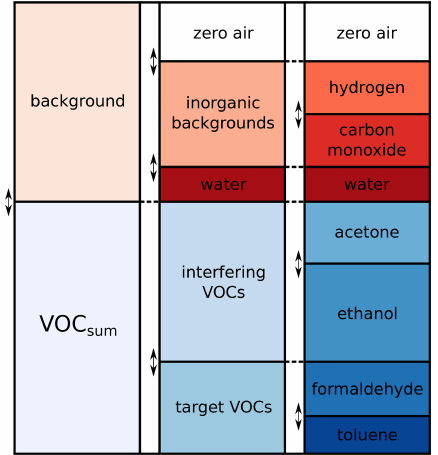
Figure 1. Gas composition for calibration consisting of random mixtures of VOCs (blue) and background gases (red; adapted from Baur et al.,